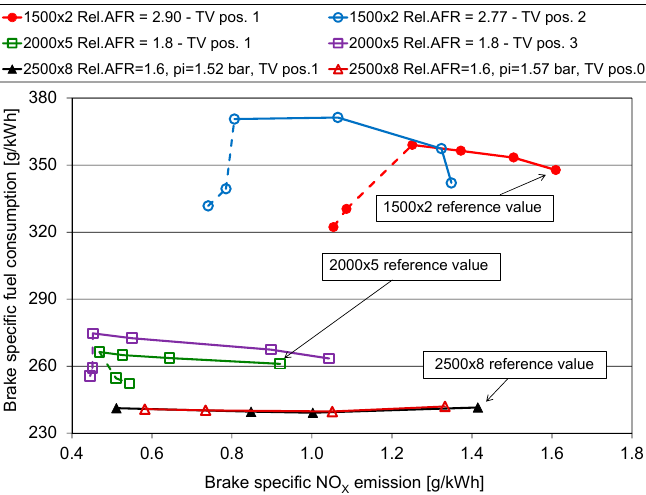
Figure 14. Trade-off between brake specific NO X emissions and fuel consumption in different operating modes.